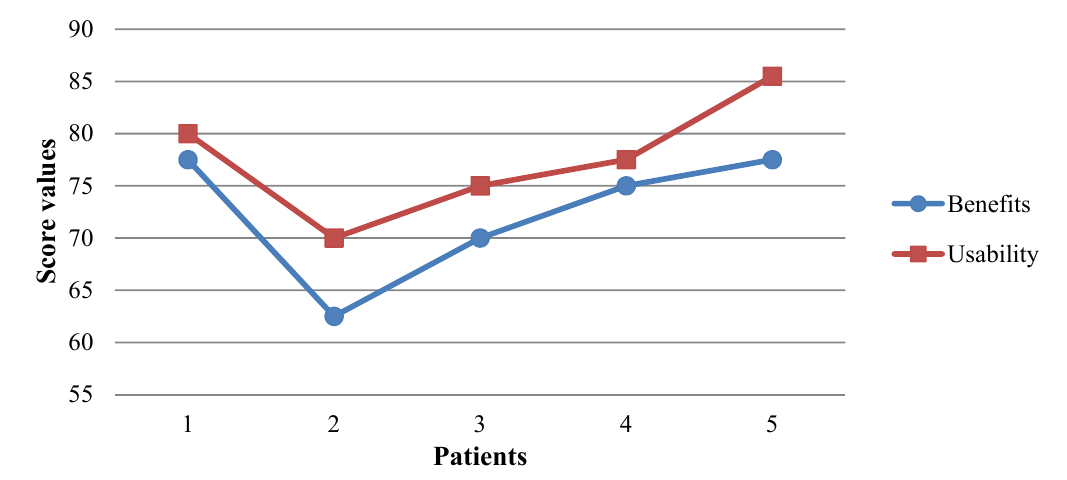
Figure 9. Results of questionnaires no. 1 and no.